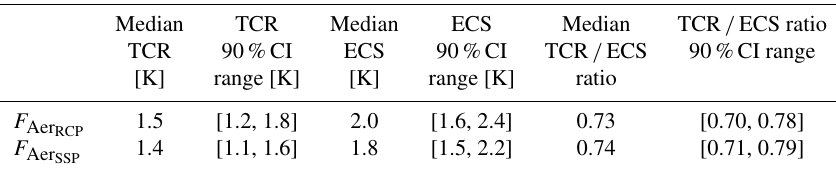
Table 2. The calculated ECS and TCR medians using both parameters corresponding to F Aer 90% credible